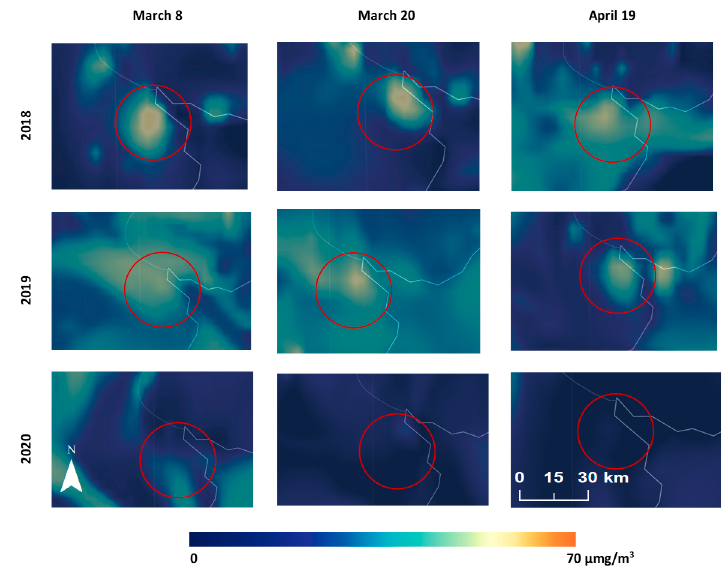
Figure A1. Satellite images obtained on 8 March, 20 March and 19 April (2018, 2019 and 2020), showing PM 2.5 levels. The city of Buenos Aires is indicated within red circle. Source: Earth (CAMS / Copernicus / European Commission + ECMWF) [31,33].